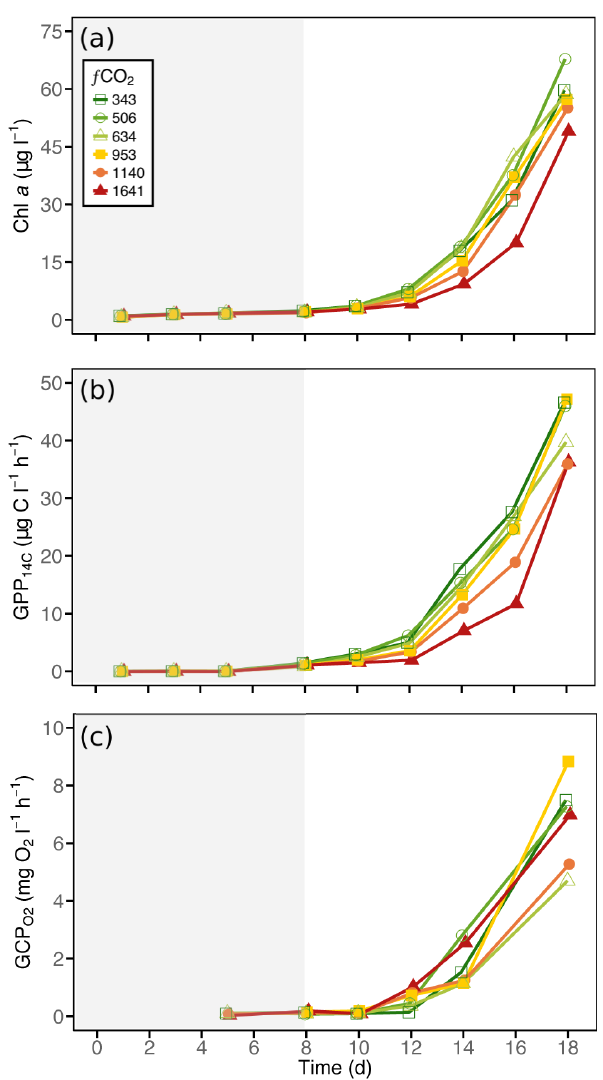
Figure 4. Particulate organic matter concentration and C : N ratio of each of the minicosm treatments over time. (a) Particulate organic carbon (POC), (b) particulate organic nitrogen (PON), and (c) car- bon : nitrogen (C : N) ratio. The dashed line indicates C : N Redfield ratio of 6.6. Grey shading indicates CO 2 and light acclimation pe- riod.